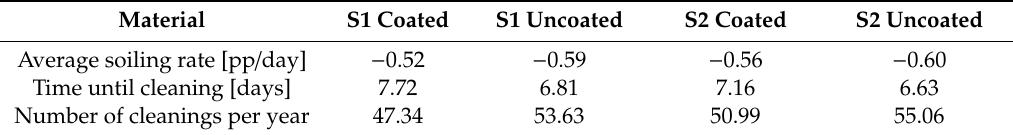
Table 2. Mean soiling rate, time until cleaning and number of cleanings per